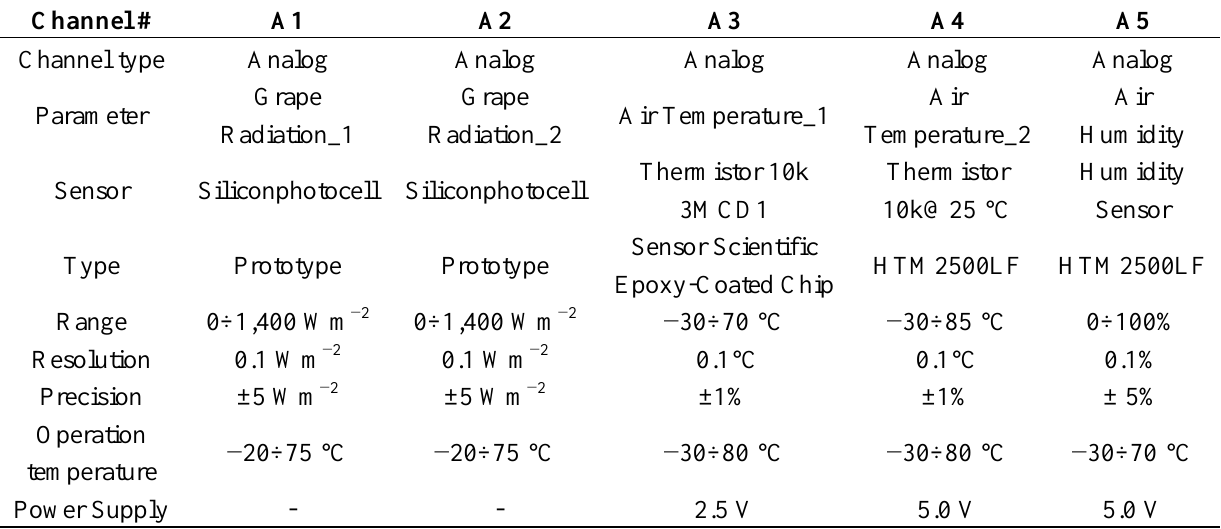
Table 2. Characteristics of the node sensors and relative on-board channels. Short sensors description, range, resolution, precision, operational temperature and power supply information are reported for each